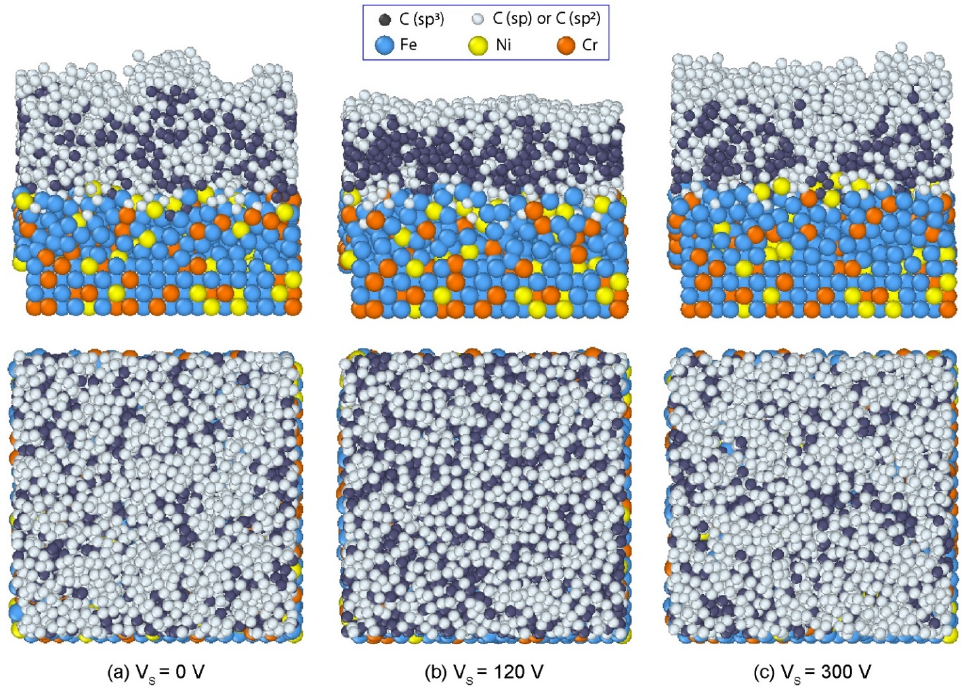
Figure 3. Structures of DLC films formed on the AISI 316L substrate with different bias voltages: ( a ) 0 V, ( b ) 120 V, and ( c ) 300 V.